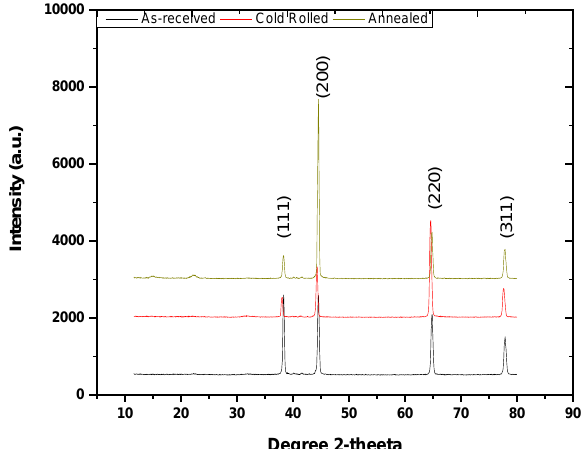
Fig. 2. XRD pattern of AA5083 alloy annealed at different